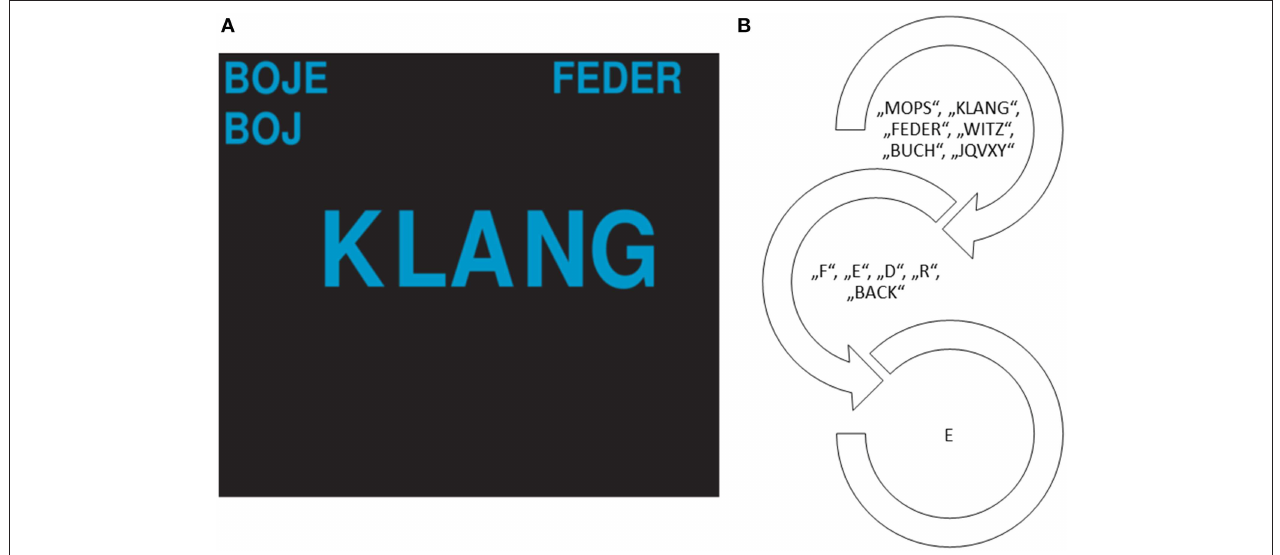
FIGURE 1 | The presentation and feedback screen in the visual paradigm (A) and the presentation in the auditory paradigm (B). The word BOJE had to be spelled and the next target letter is E so the target stimulus word is